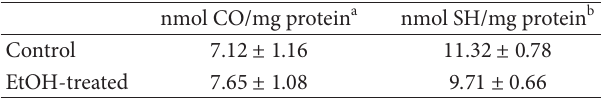
Figure 4: t -Butylhydroperoxide induced chemiluminiscence in rat uterine horn homogenates from rats receiving an alcohol containing liquid diet. Rat uterine horn tissue homogenized in 0.25 M sucrose, 50 M deferoxamine in TKM buffer, pH 7.5 ( ≈ 7mg protein/mL) was kept at 37 ∘ C for 10min in a Dubnoff shaker. Chemilu- miniscence measurement was started by addition of 3 mM t - butylhydroperoxide. Values are the mean ± S.D. Three samples per group were run, each consisting of a homogenate from a separate lot of pooled uterine horn tissue (five animals each). Table 4: Protein sulfhydryl and protein carbonyl in uterine horn from rats receiving an alcohol containing liquid